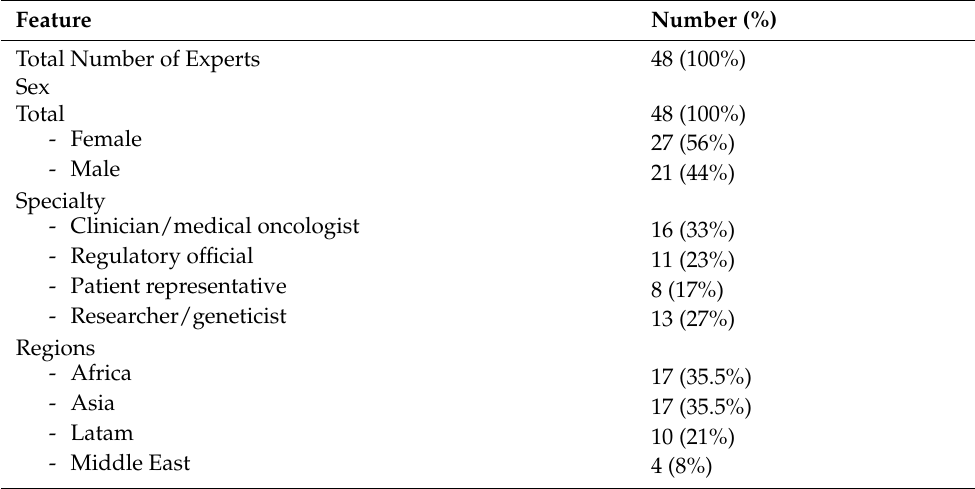
Table 1. Characterization of experts involved in series of panels organized by